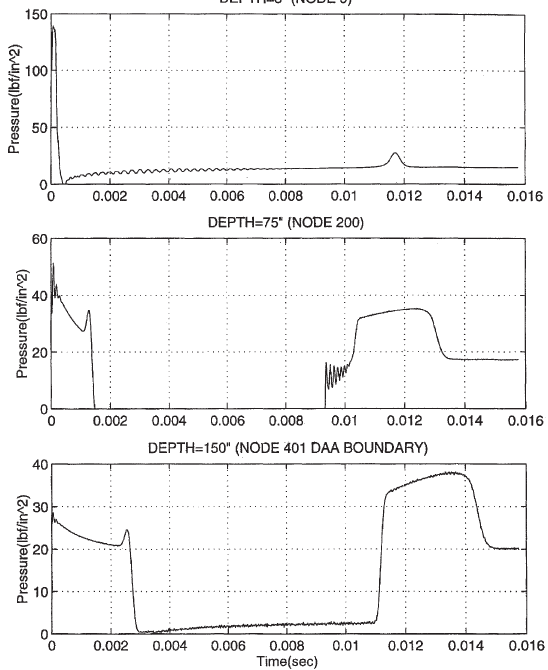
Fig. 3. Fluid pressure at the depth of 3 00 , 75 00 and 150 00 (DAA bound- ary) for Bleich–Sandler model (CFA on).